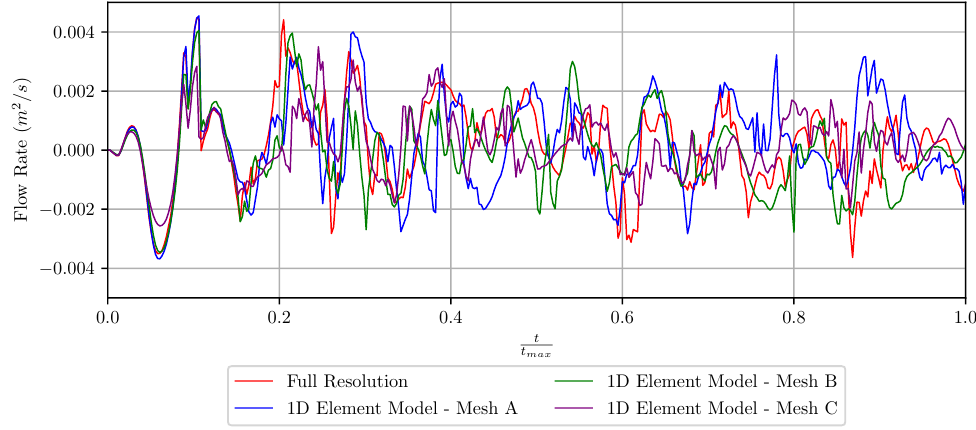
Figure 16. Flow rate through middle orifice in violent slosh test case using one-dimensional orifice element model.